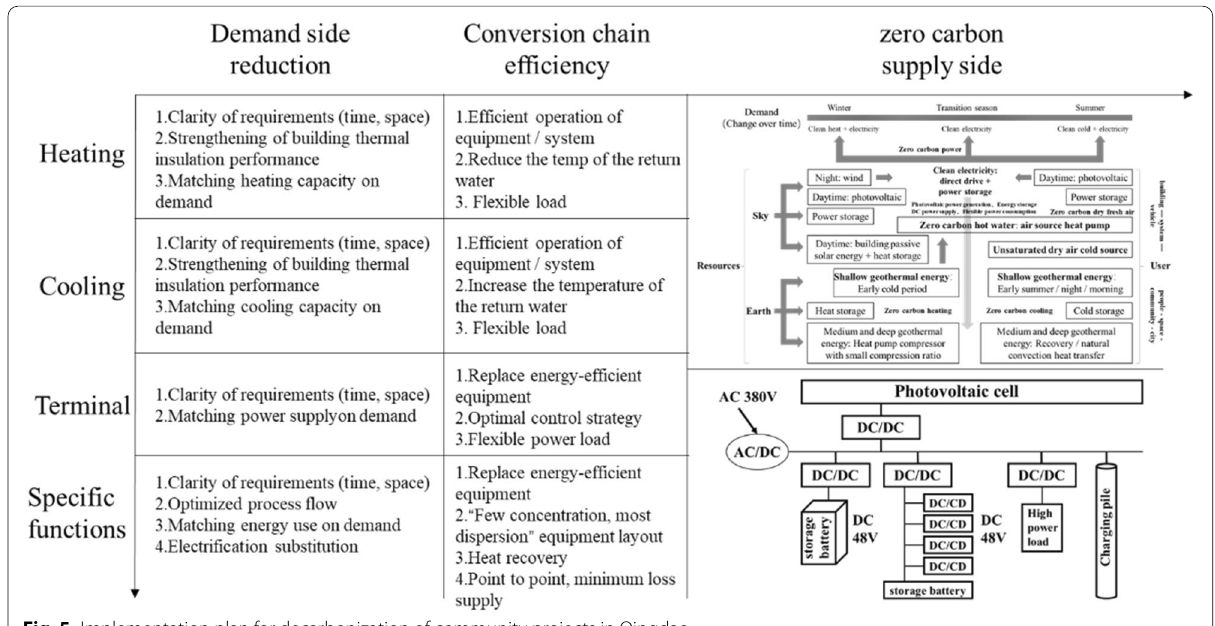
Fig. 5 Implementation plan for decarbonization of community projects in